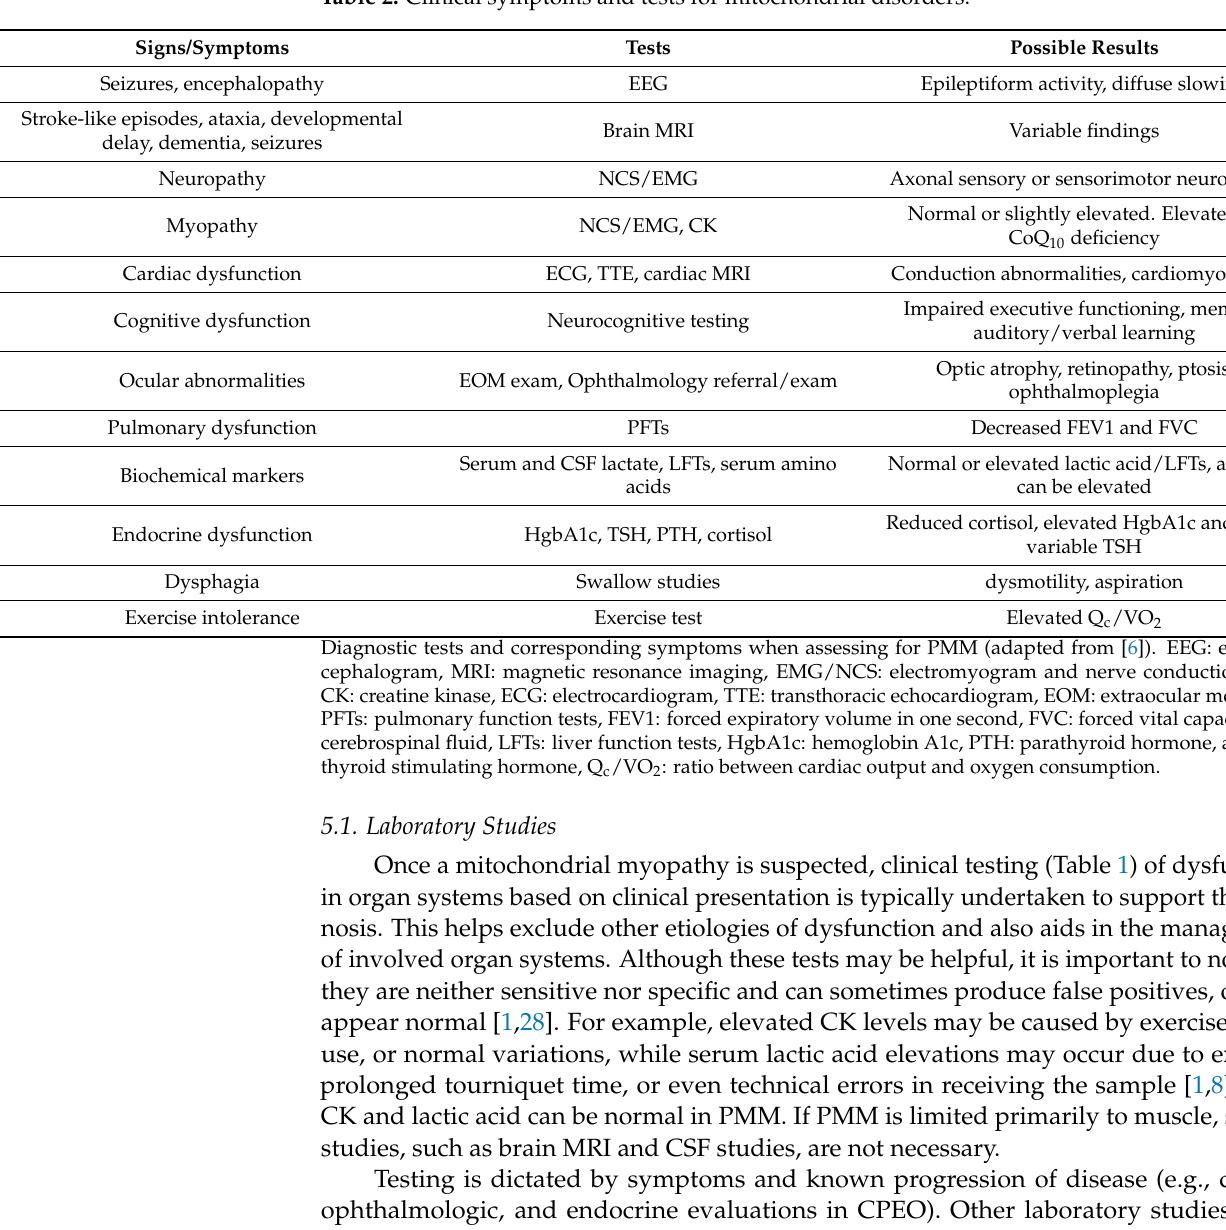
Table 2. Clinical symptoms and tests for mitochondrial